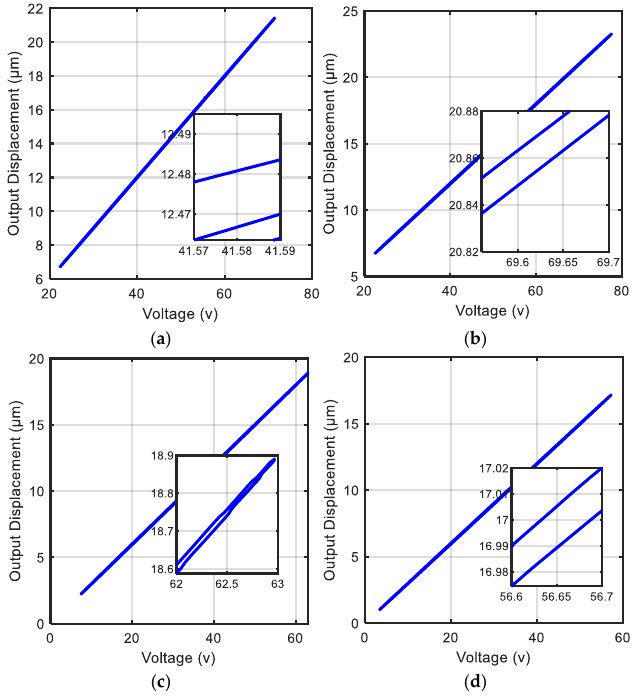
Figure 17. The effect of the proposed control scheme on hysteresis loops of the considered piezoe- lectric actuator. The loops shown were obtained by: ( a ) test reference H; ( b ) test reference I; ( c ) test reference J; and ( d ) test reference K.